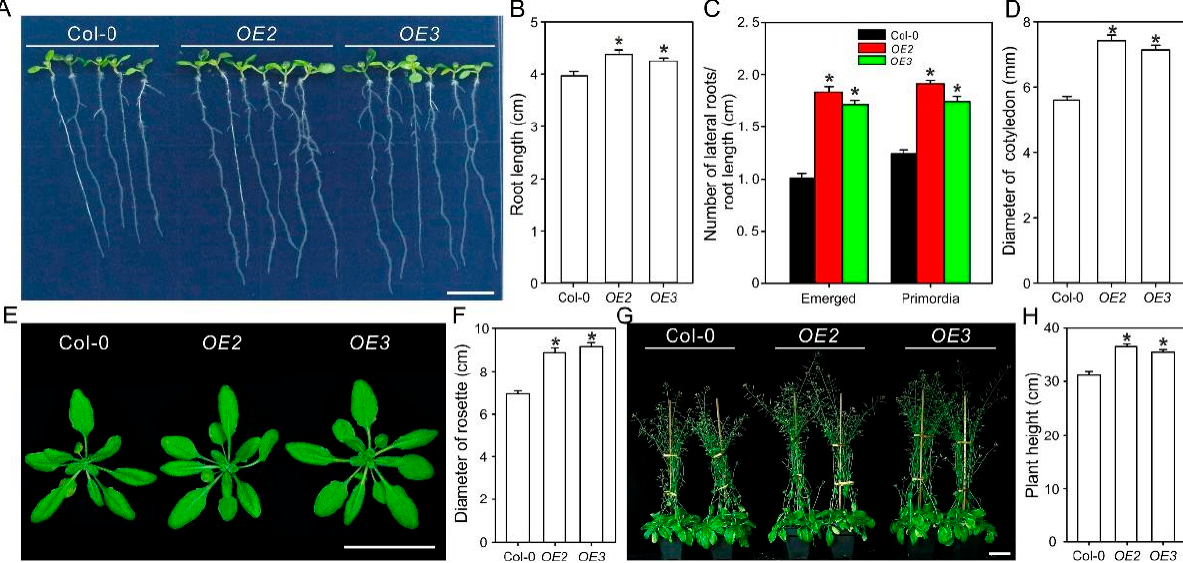
Figure 2. ZxPIP1;3 plays positive roles in plant growth. ( A ) Phenotypes of wild-type (Col-0) and ZxPIP1;3 overexpression lines ( OE2 and OE3 ) grow vertically on 1/2 Murashige and Skoog (MS) medium for 7 days after germination. Bar = 1 cm. ( B – D ) Primary root length ( B ), number of emerged lateral roots and lateral root primordia ( C ) as well as cotyledon diameter ( D ) of plants treated as described in the legend of ( A ). ( E ) Phenotypes of 4-week-old seedlings grown on soil culture. Bar = 5 cm. ( F ) Rosette leaves diameter of plants treated as described in the legend of ( E ). ( G ) Phenotypes of 7-week-old seedlings on soil culture. Bar = 5 cm. ( H ) Height of plants treated as described in the legend of ( G ). For ( B – D ), ( F , H ), asterisks indicate significant differences from Col-0 ( n = 13 per column. * p < 0.05, one way ANOVA).